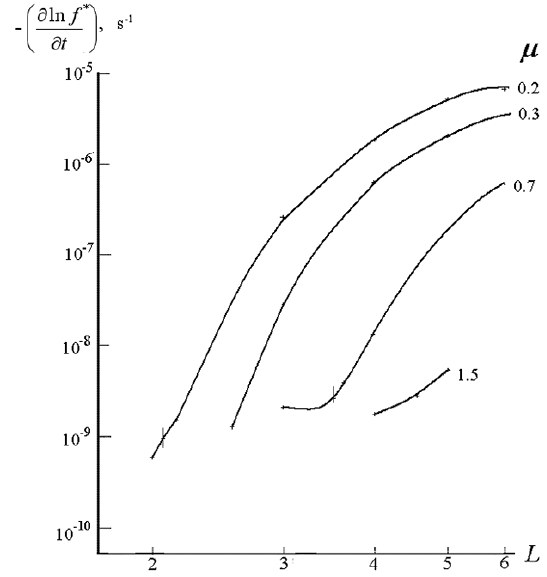
Figure 4. The same as in Fig. 3 for the Explorer-45 data from Fritz and Spjeldvik (1981) for the period of 1–15 June 1972. Here µ is given in kiloelectronvolt per